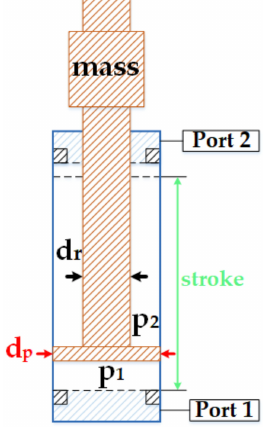
Figure 4. State analysis of hydraulic cylinder